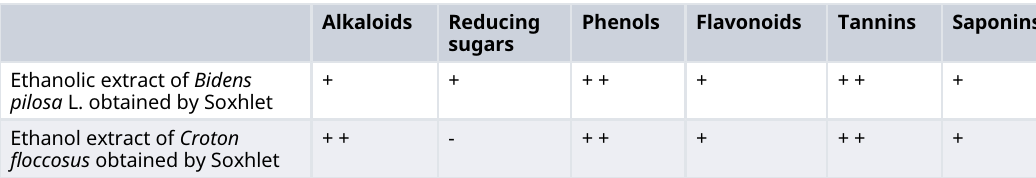
Table4. Results of thephytochemical testscarried outontheethanolicextracts of thespecies Bidens pilosa L. and Croton floccosus obtained with Soxhlet